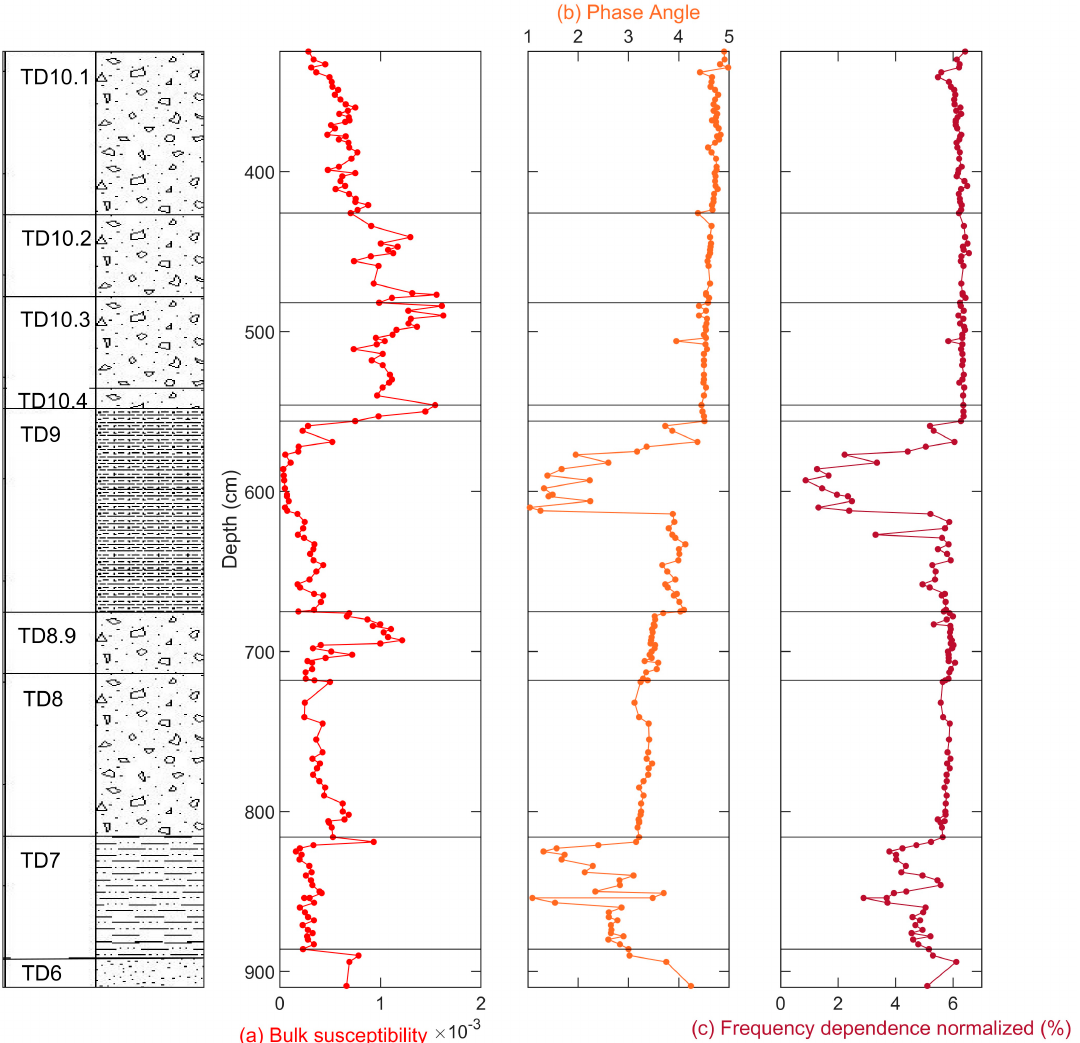
Figure 6. Magnetic susceptibility parameters, all dimensionless (in SI units), subdivided by units (from TD6 to TD10.1, base to top respectively): ( a ) Bulk susceptibility; ( b ) Phase angle parameter; ( c ) Normalized frequency-dependence parameter. Simpli fi ed stratigraphic log to the left.